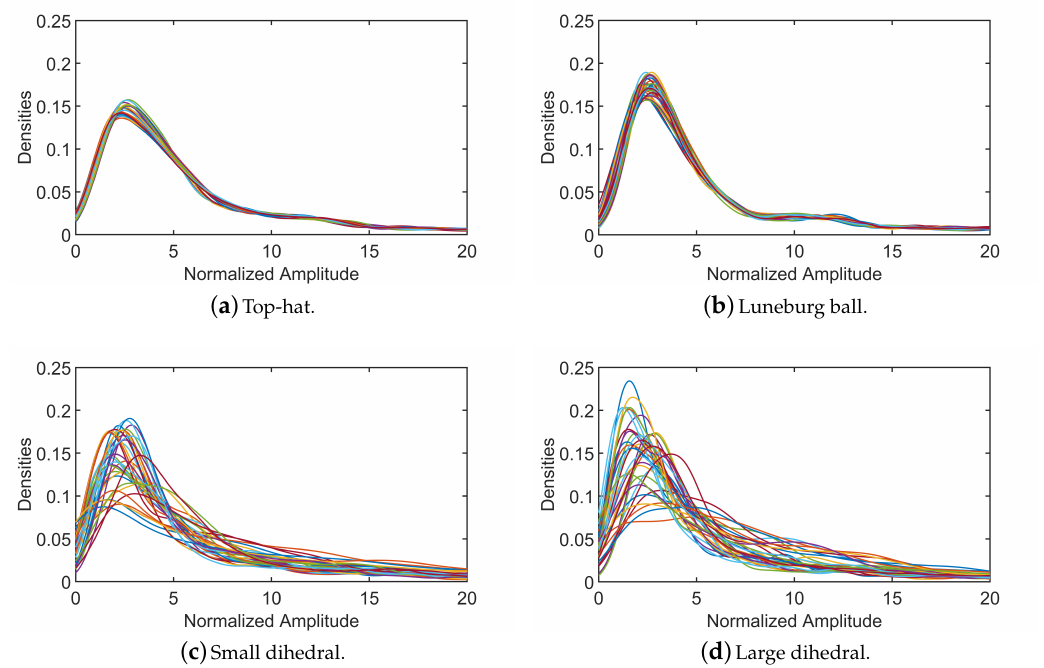
Figure 5. The PDFs of targets under different aspect angles. ( a ) Top-hat. ( b ) Luneburg ball. ( c ) Small dihedral. ( d ) Large